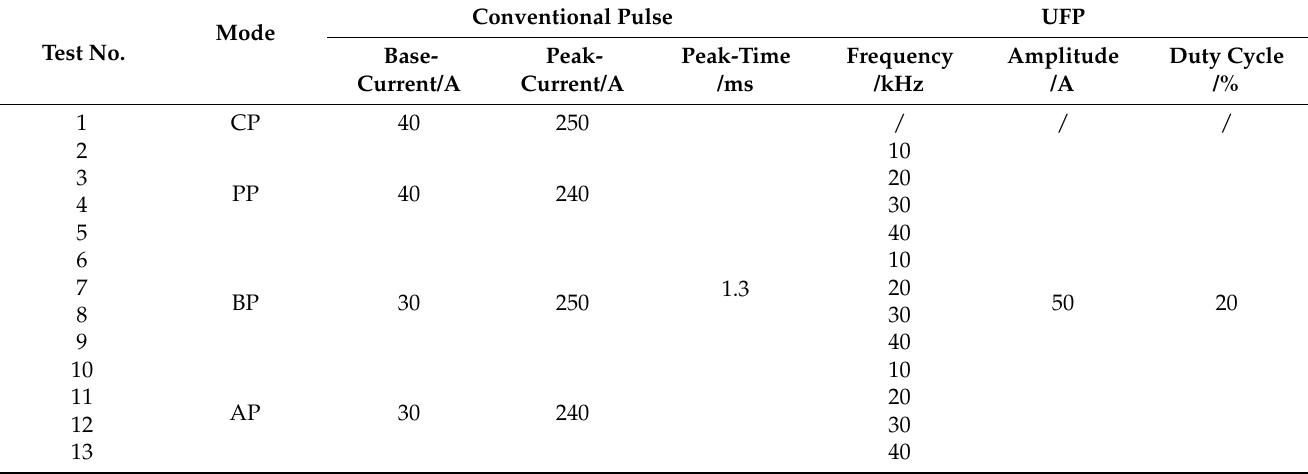
Table 1. Current parameters of the welding power.